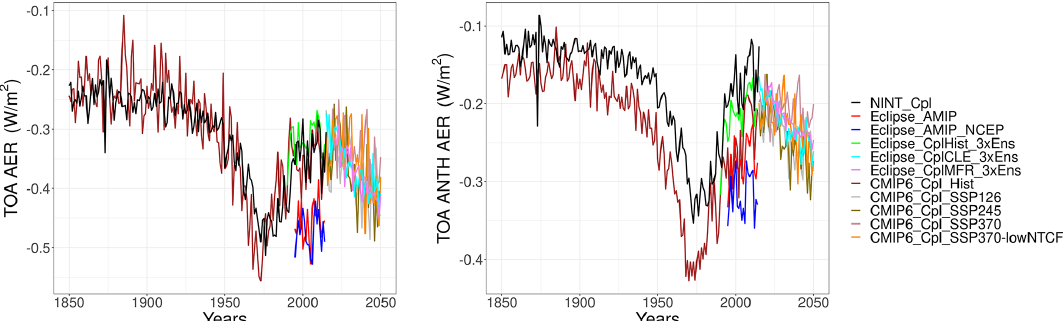
+ NO − + Dust + SSA) and only anthropogenic aerosols 4 3